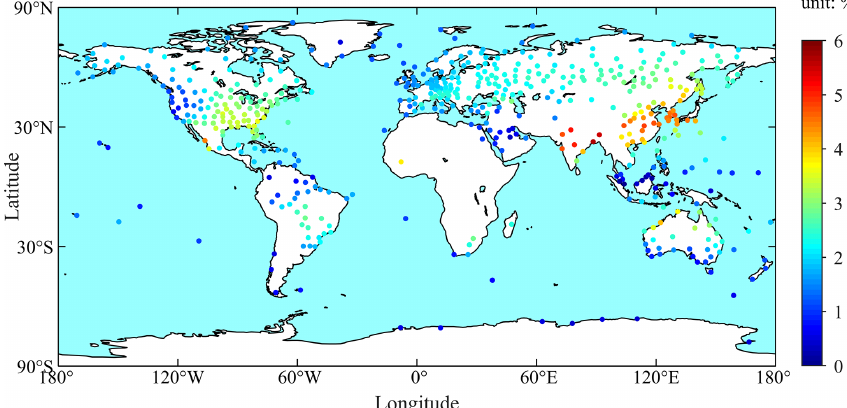
Figure 3. Annual amplitude of the ratio of total and hydrostatic zenith delays at each of the 505 global radiosonde